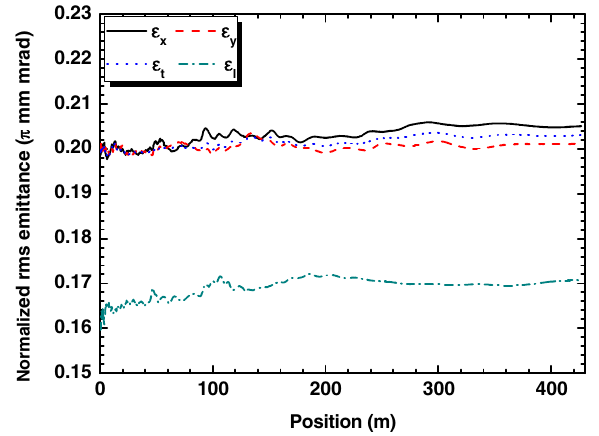
FIG. 7. Evolutions of the rms emittances along the